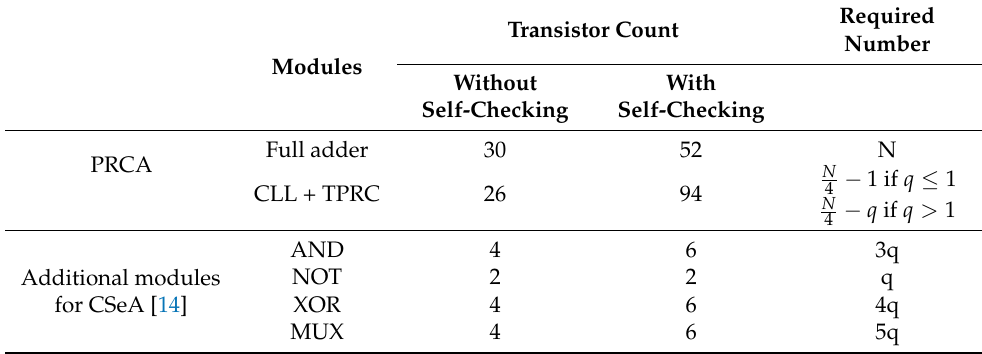
Table 1. Transistor count for different modules.